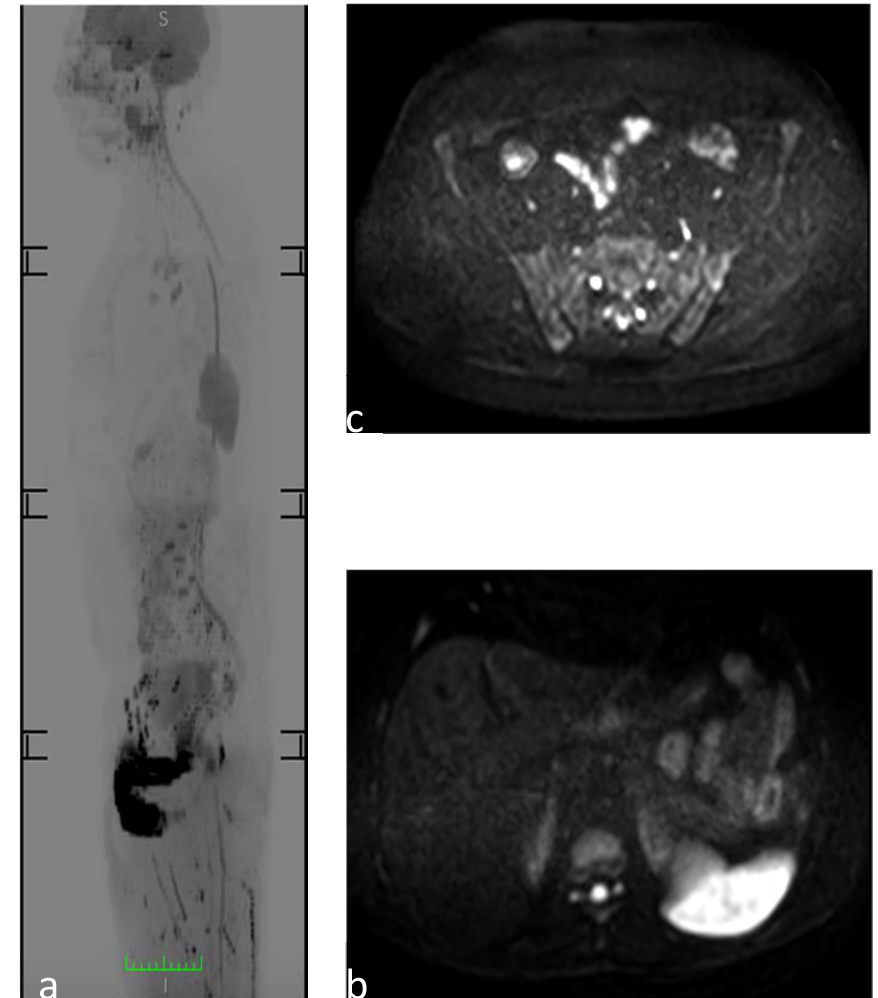
Figure 1. WB-MRI to study a 30-year-old man. ( a ) Sagittal reformatted diffusion-weighted image MR images (inverted gray scale, high b values, b 1/41,000 s/mm 2 ) showing a physiological restriction to diffusion of the spleen and genitourinary system. ( b ) Axial DWI image at the level of the upper abdomen showing the physiological restriction to diffusion of the spleen and the “t2 shine through artifact” of the medullary canal. ( c ) Axial DWI image at the level of the sacroiliac joint, which does not show the pathological areas of restriction to diffusion of the osteoarticular structures.